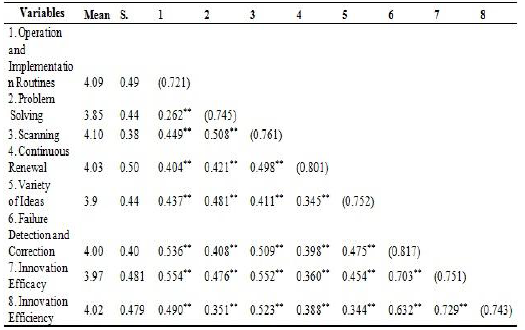
Table 2: Research and Development Activities of the